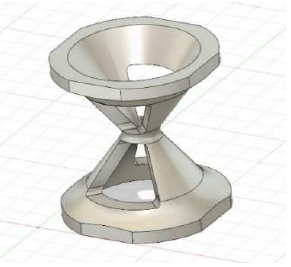
J. Compos. Sci. 2022 , 6 , x FOR PEER REVIEW Figure 3. Acoustic foam inspired unit cell (4 × 4 × 8 mm 3 ). Figure 3. Acoustic foam inspired unit cell (4 × 4 × 8 mm 3 ).